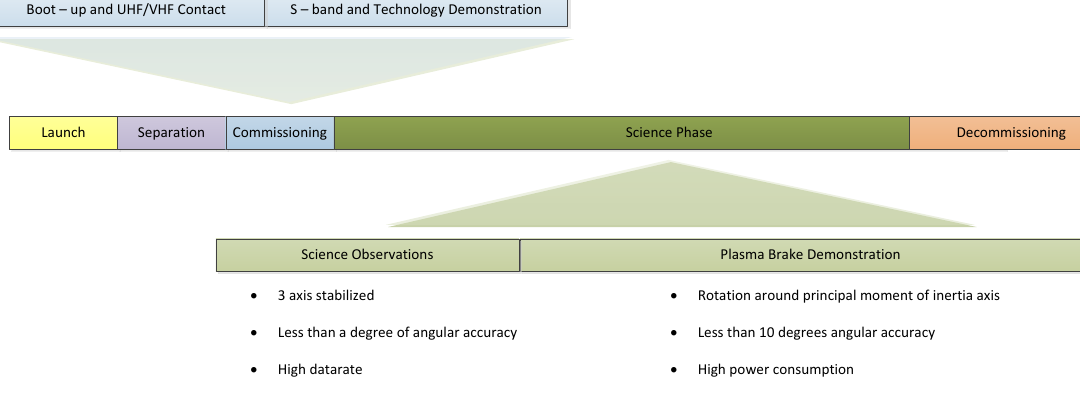
Fig. 5. The commissioning phase will consist of booting up the satellite, making contact with ground and performing the required technical demonstration for the spectral imager and RADMON. The science phase is divided into two specific parts based on attitude and downlinking communication